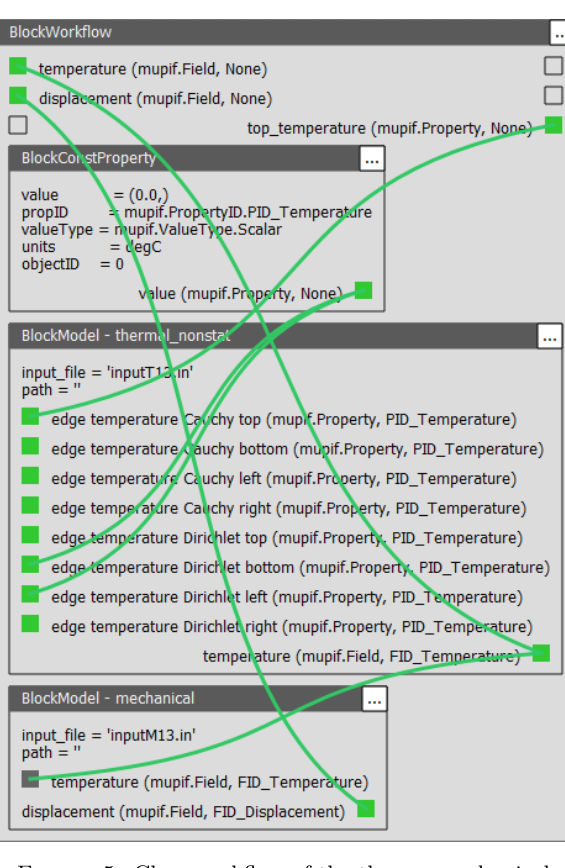
Figure 5. Class workflow of the thermo-mechanical simulation.